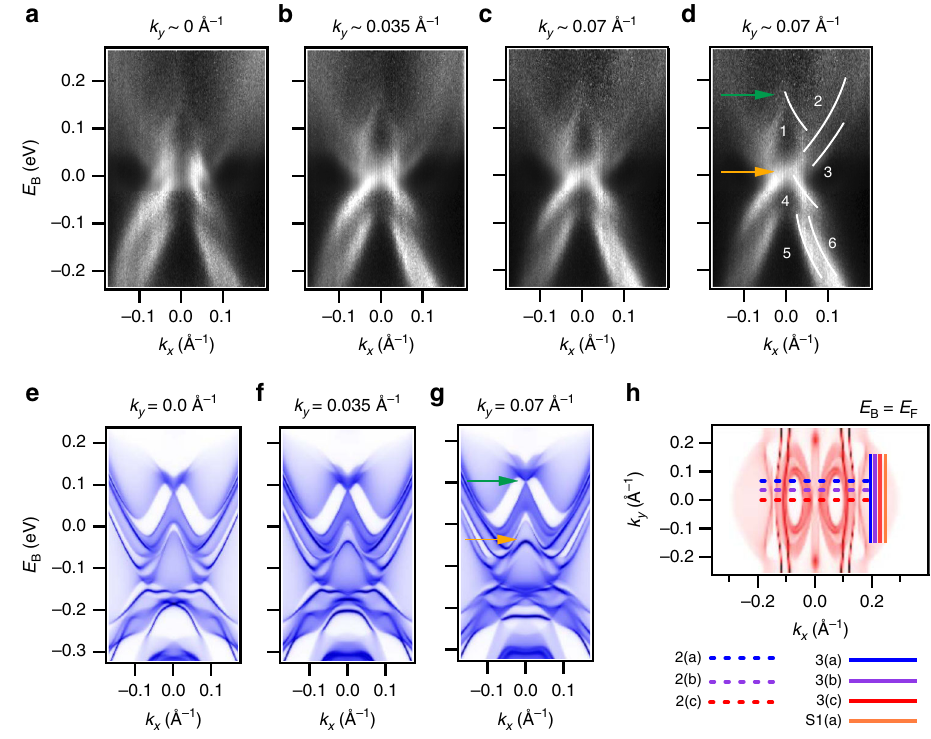
Fig. 2 Unoccupied electronic structure of TaIrTe 4 . a – c Pump-probe ARPES dispersion maps of TaIrTe 4 , showing dispersion above E F at fi xed k y near Γ . d Same as c but with key features marked. e , f Ab initio calculation of TaIrTe 4 . The data is captured well by calculation, but the sample appears to be hole doped by ~50 meV, comparing the green and orange arrows in d , g . h Calculation of the nominal Fermi surface, showing weak dispersion along k y near Γ , consistent with the data. All cuts in Figs. 2 and 3 and Supplementary Fig. 1 are marked ( solid and dashed lines